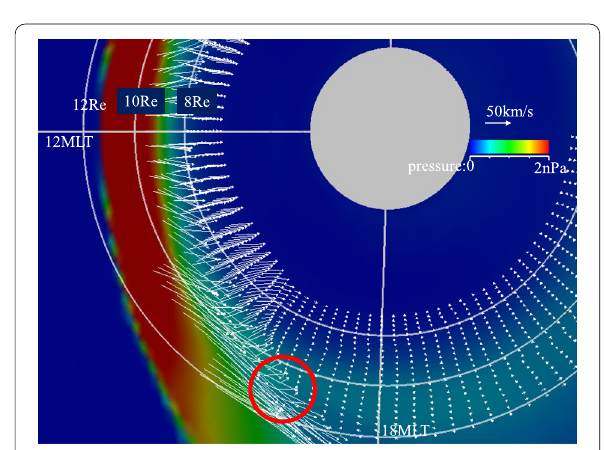
Fig. 8 Vectors of the plasma flow perpendicular to the magnetic field in the post-noon sector of the equatorial plane at 5.5 min. The pressure distribution in the equatorial plane is shown with color shading. See Fig. 6 caption for the description of the red